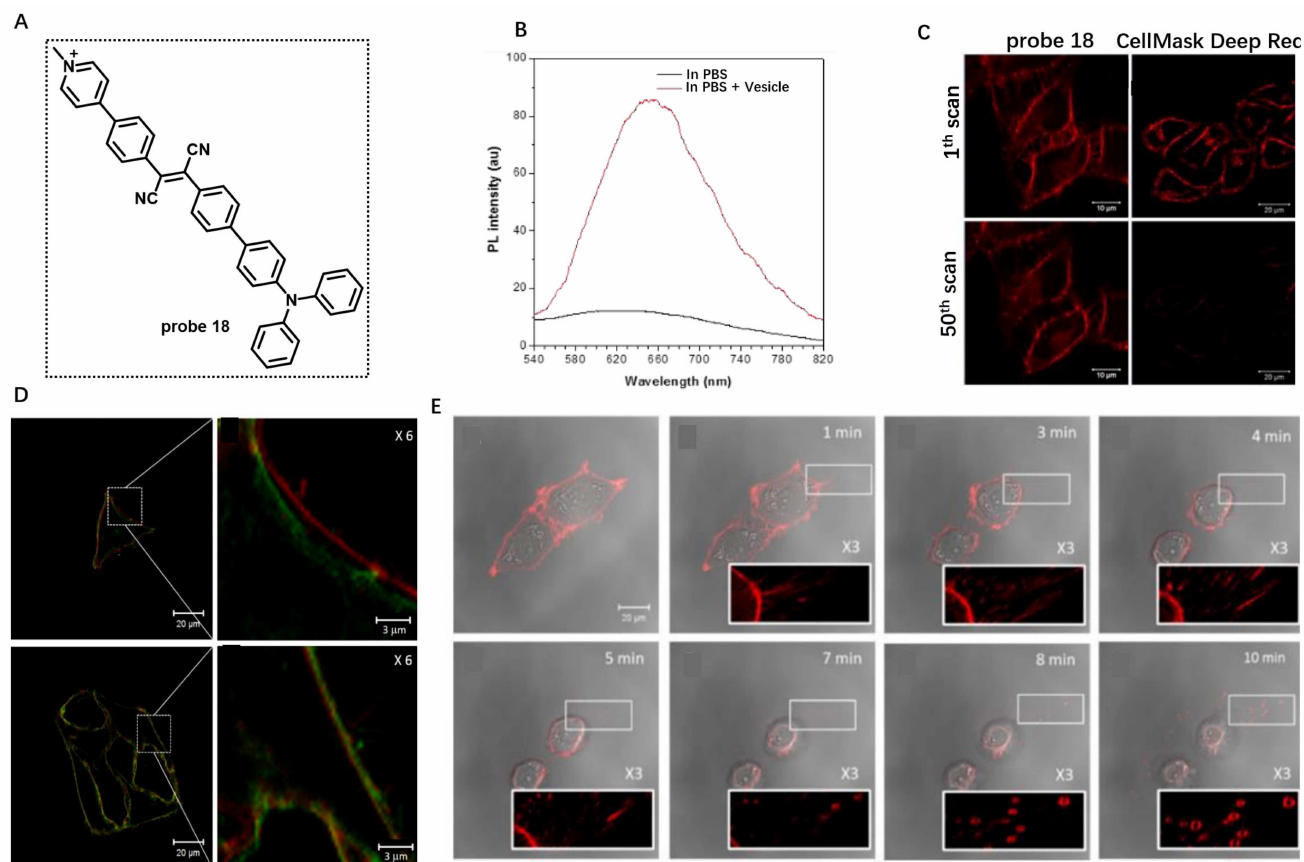
Figure 18. ( A ) Chemical structure of probe 18 . ( B ) PL spectra of probe 18 in the absence or presence of lipid vesicle. ( C ) The photostability of probe 18 in HeLa cells by continuous scanning. ( D , E ) Moni- toring morphology changes in CM using probe 18 . Copyright 2018 Royal Society of Chemistry